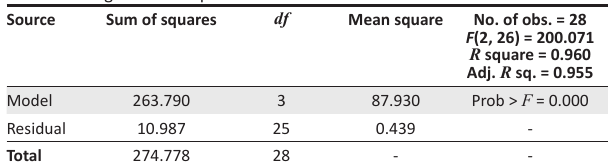
TABLE 4a: Organisational